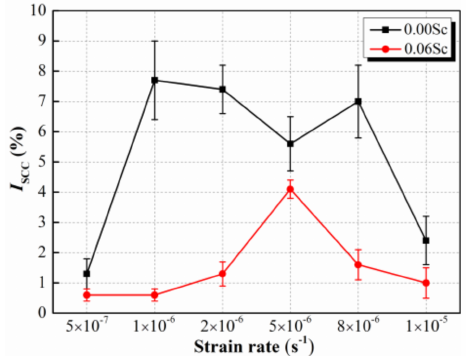
Figure 5. Stress corrosion cracking (SCC) susceptibilities of two aged alloys at different strain rate in neutral 3.5% NaCl